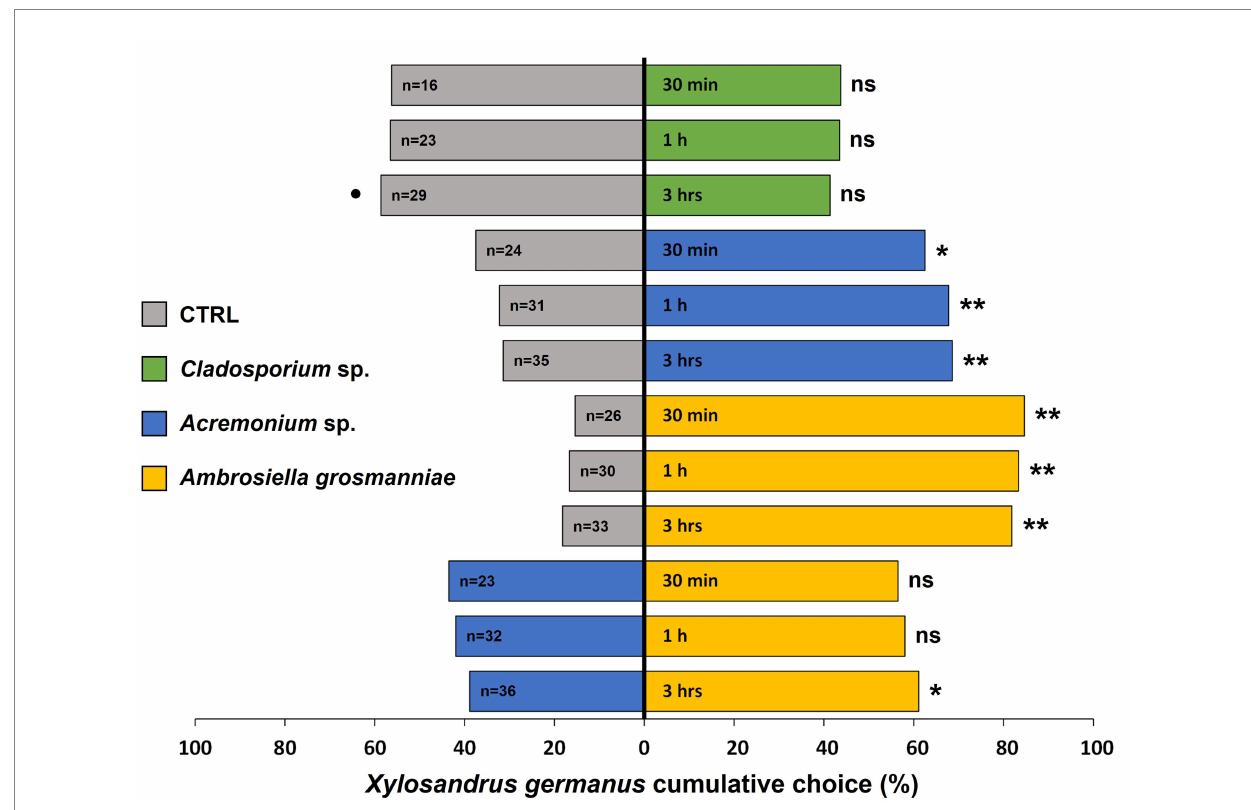
FIGURE 1 Xylosandrus germanus response to volatiles emitted by: (i) its main nutritional symbiont Ambrosiella grosmanniae (most common fungus in our study), indicated by yellow bars; (ii) Acremonium sp. (the second fungal species consistently found in association with dispersing females in our study), indicated by blue bars; (iii) Cladosporium sp. (tested as representative non-symbiont), indicated by green bars; and (iv) PDA control, indicated by grey bars. A total of 40 beetle females were tested for each combination of volatile sources. The choice between different sources was monitored at 30 min, 1 h, and 3 h. Asterisks denote significant differences: * p < 0.05; ** p < 0.001. ns, not significant. • p < 0.1. n , number of insects choosing a volatile